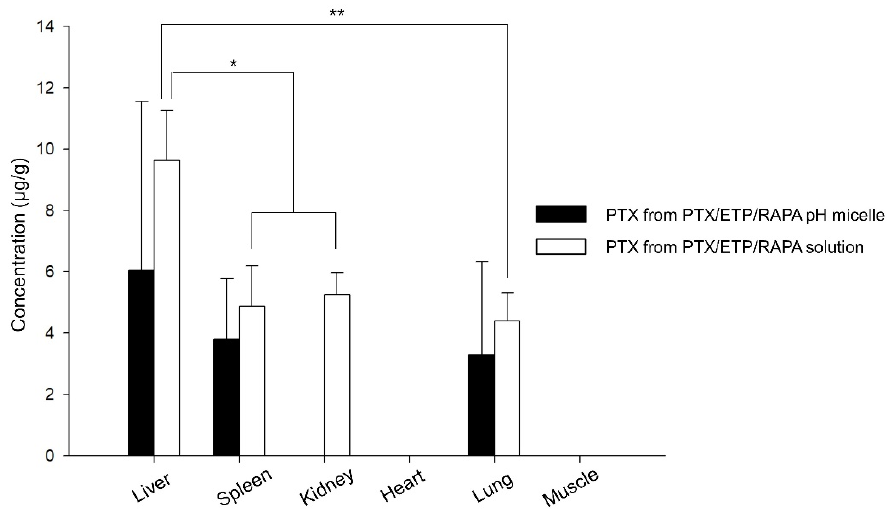
Figure 7. Biodistribution of PTX in PTX/ETP/RAPA-loaded mPEG-pH-PCL micelles and PTX/ETP/RAPA solution in each tissue at 8 h after intravenous injection (* p < 0.05, ** p < 0.01) (n =